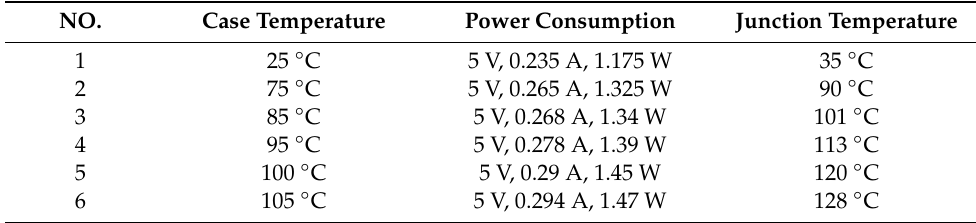
Table 1. SiP chip (Zynq) high temperature test